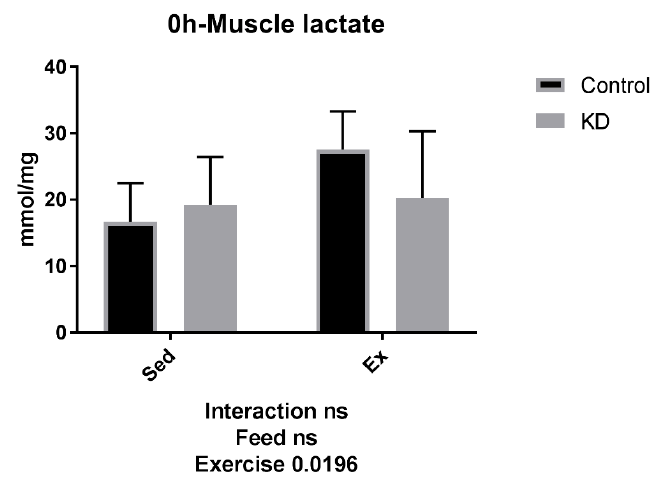
Figure 2. Locomotion time of mice ( A ) immediately or ( B ) 24 h after exhaustion as indicated. * p < 0.05 compared with indicating column, @ p < 0.05 compared with KDE, # p < 0.05 compared with Ex.